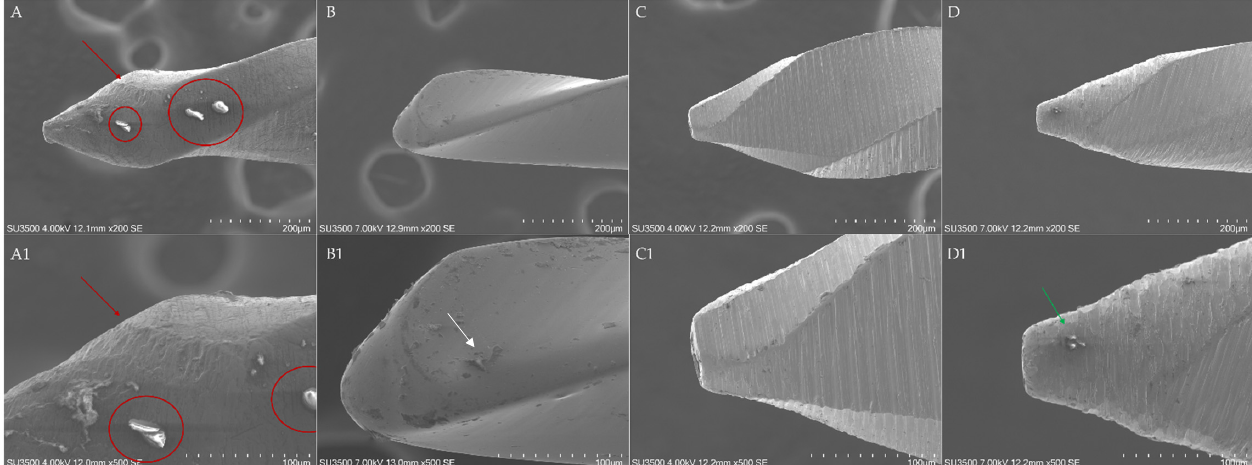
Figure 2. Sem images of tips of as-received four brand instruments. On the upper line are represented micrographs of the four instruments tips acquired at 200 × magnification, whilst on the bottom line are represented micrographs at × 500 magnification. ( A , A1 ) EOF tip, in which are shown metal defects such as microcavities and grooves (red arrows) and metal debris (red circle) respectively at × 200 and × 500 magnification. ( B , B1 ) OR tip, in which are shown a smoother surface arising from proprietary surface treatment, at higher magnification ( × 500) some small debris can be noted (white arrows). ( C , C1 ) WOG tip, in which are shown at different magnification (respectively, × 200 and × 500) the typical surface texture characterized by regular marks perpendicular to the longitudinal axis of the instrument. No debris and defects are noted. ( D , D1 ) R25 Blue tip, in which are shown at different magnification (respectively × 200 and × 500) the typical surface texture characterized by regular marks perpendicular to the longitudinal axis of the instrument. Small debris are noted (green